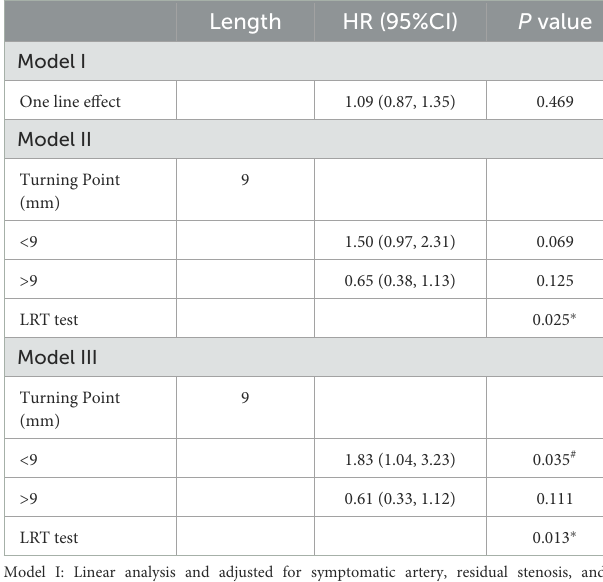
TABLE 4 Threshold effect analysis of the relationship between lesion length and RCI in the BES group.